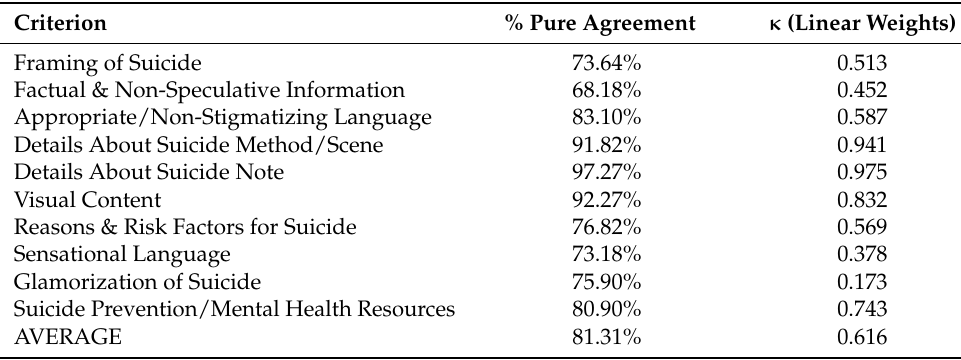
Table 3. Pure Agreement and Weighted Kappa Values by